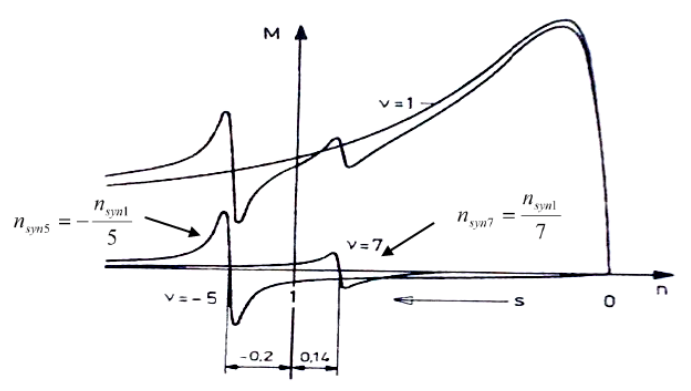
Figure 4. ASM torque characteristics with asynchronous torque dips [3] .